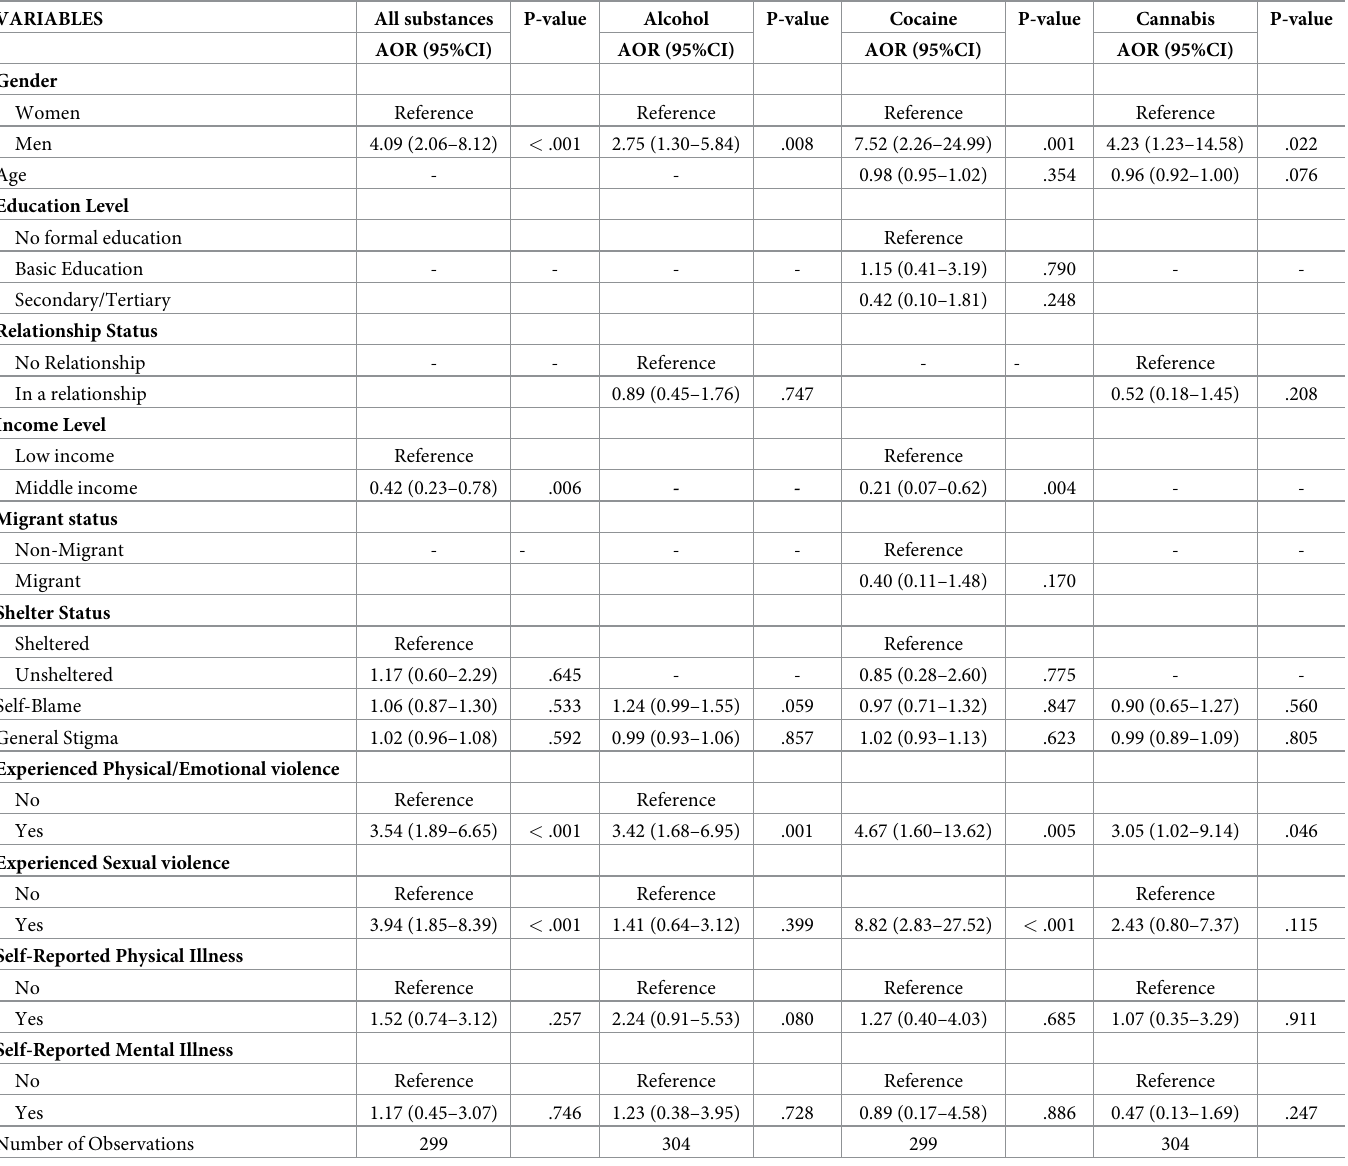
Table 4. Adjusted odds ratios for having assist-defined high-risk substance